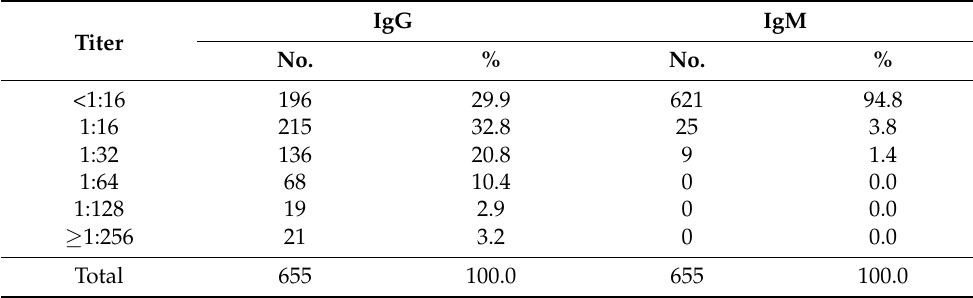
Table 1. Serologic results for Borrelia burgdorferi antigen among National Park Office forestry workers in South